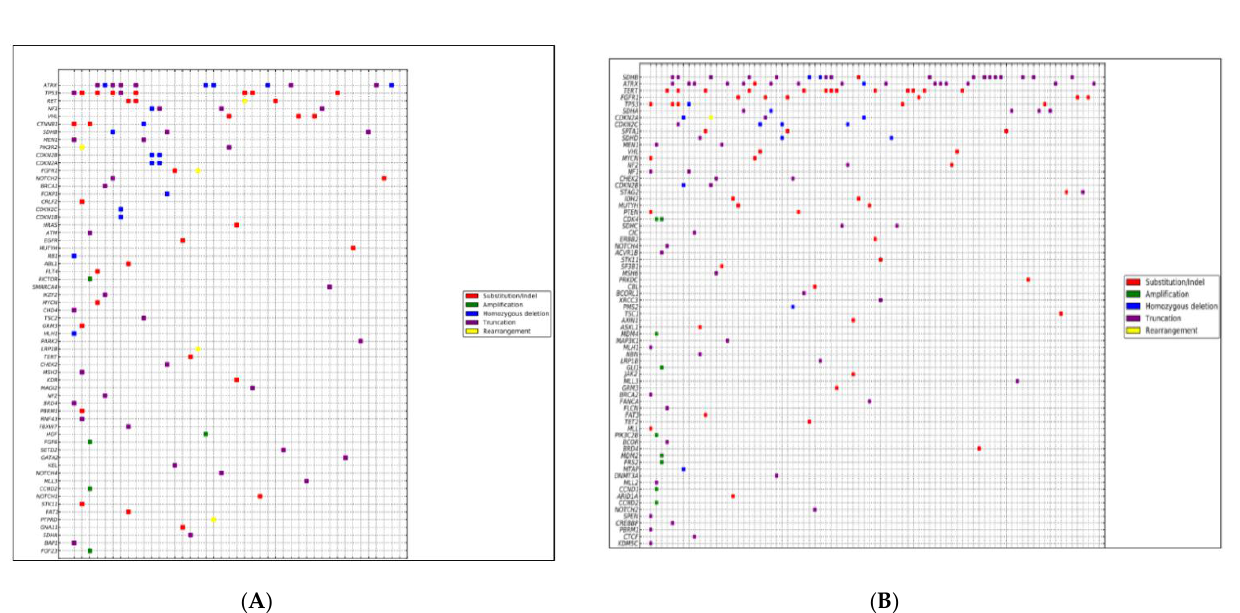
Figure 1. Dot blot charts showing the frequencies of genomic alterations per tumor for the CA-Pheo Figure ( A ) and CA-Para Figure ( B ) patients.